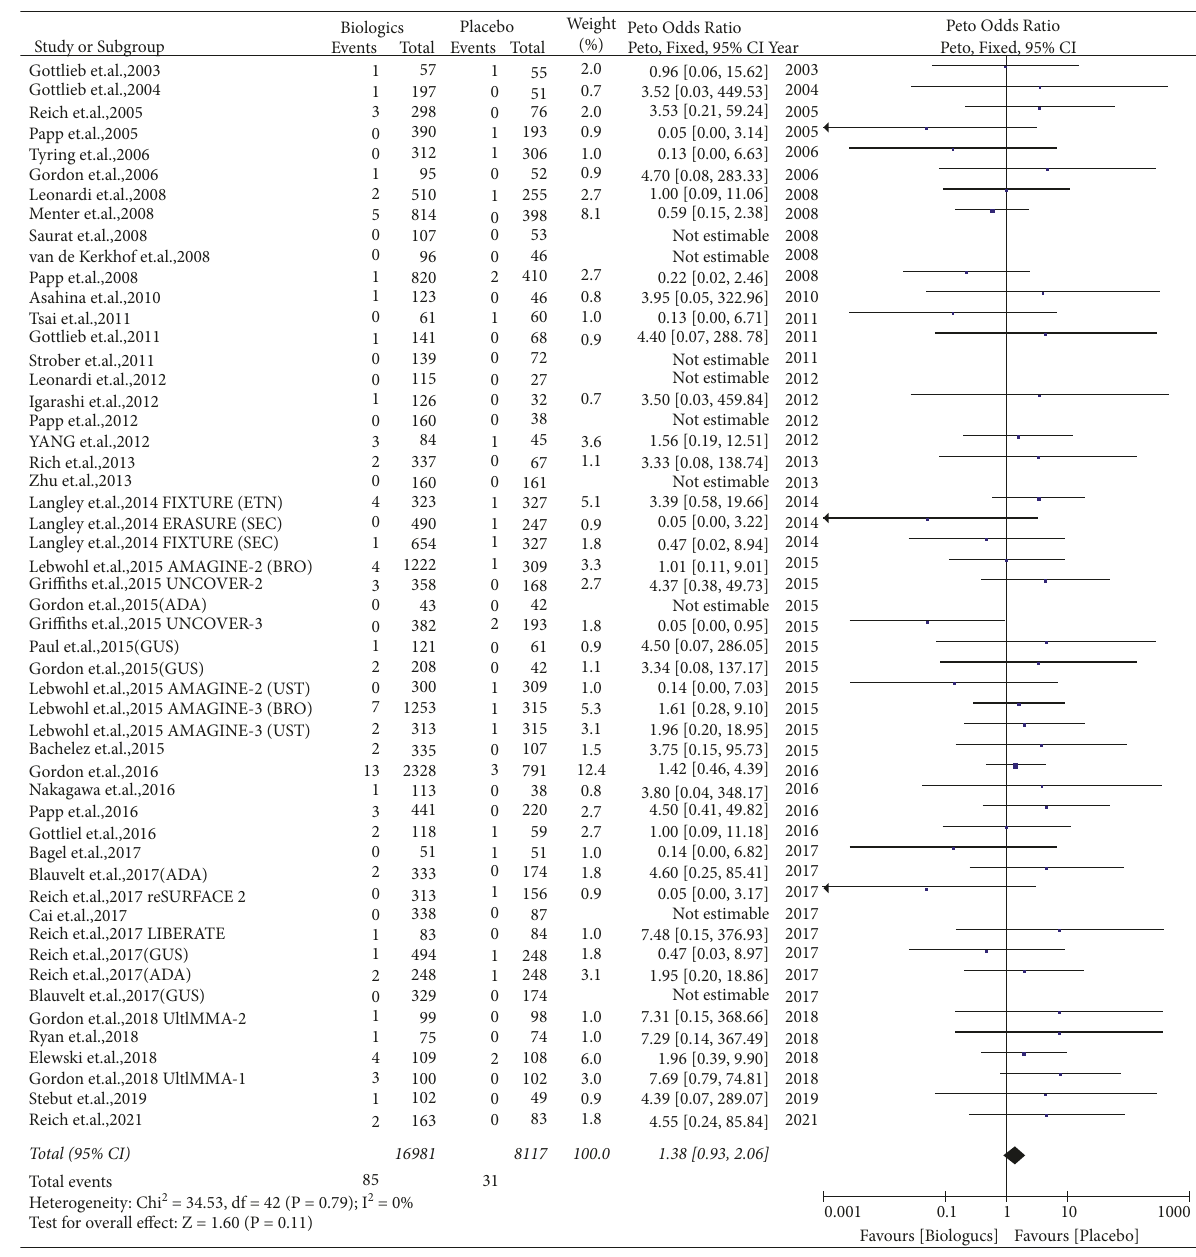
Figure 5: Forest plot of pooled data regarding serious infections between biological agents and placebos. CI, confidence